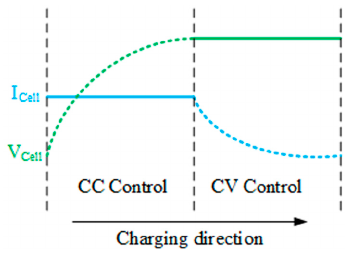
Figure 5. CC–CV control of Li-ion battery charging.